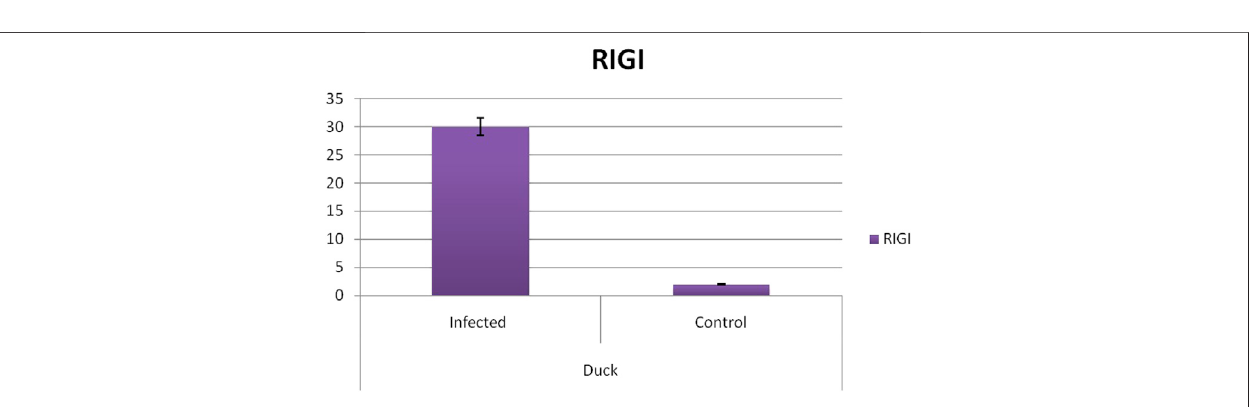
FIGURE 14 | Differential mRNA expression pro fi ling for RIGI gene with respect to infected versus control Bengal duck and HB Chicken.